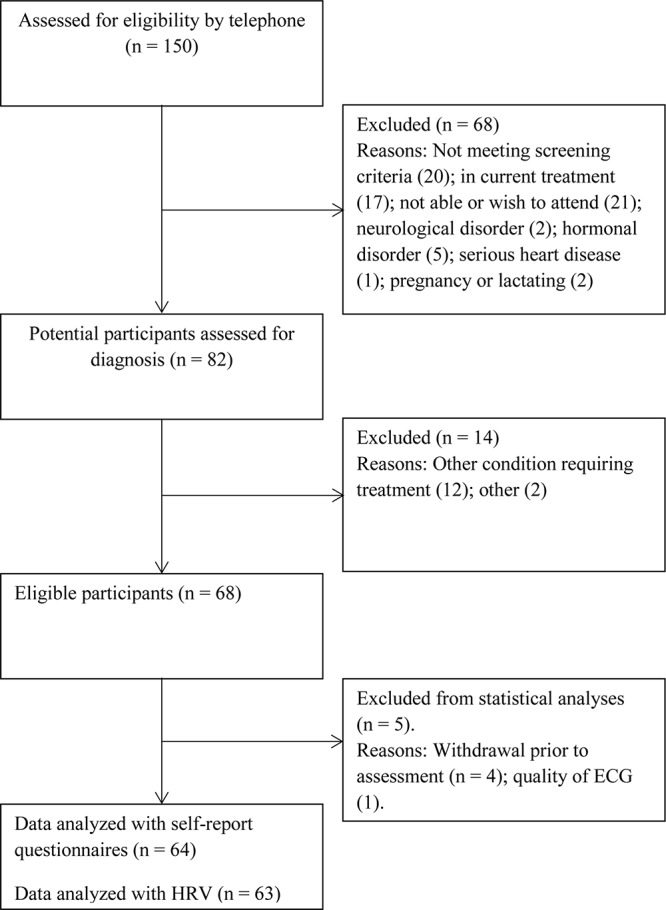
Participant flow.